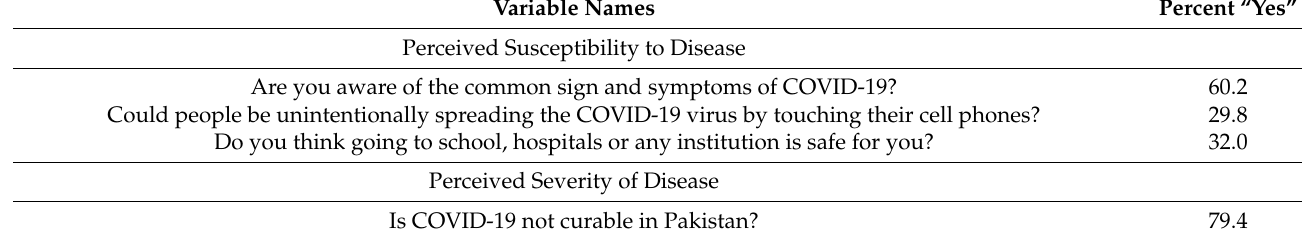
Table 2. Descriptive Statistics for Items, by the Health Belief Model Constructs, Depalpur City, Pakistan, 2020 [N = 500]. Variable Names Percent “Yes” Perceived Susceptibility to